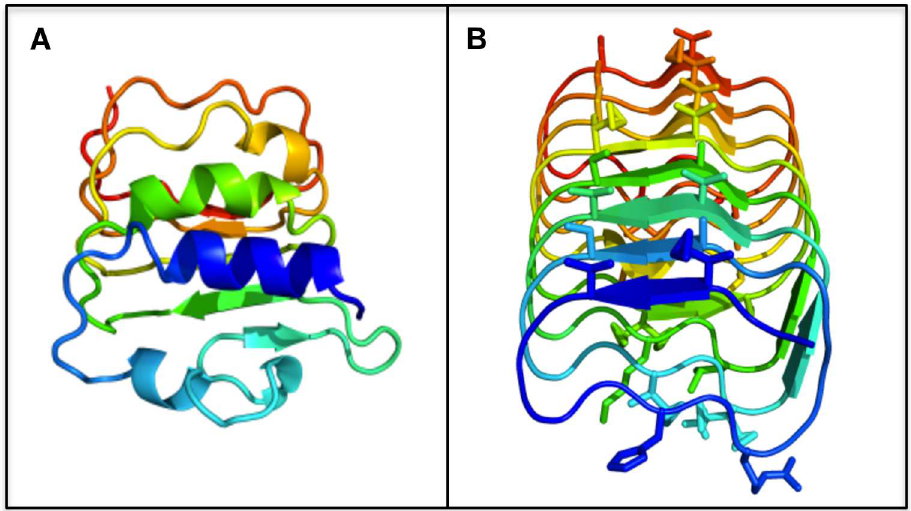
Fig 2. Structural model of the Bd IRI1 protein sequence. The amino(N)- (A) and carboxyl(C)- (B) terminal domainswere modeledindividually using the Phyre2 algorithm. The N-terminal domainmodeledto A . thaliana FLS2 (At5g46330.1) crystal structure correspondingto a flagellinreceptorprotein. The C-terminal domainwas modeledto the crystal structure of Lp AFP (AJ277399), an IBP identifiedin L . perenne . Putative ice-bindingresidues identifiedon the flat surfaces of the C-terminal domainare shown as sticks.